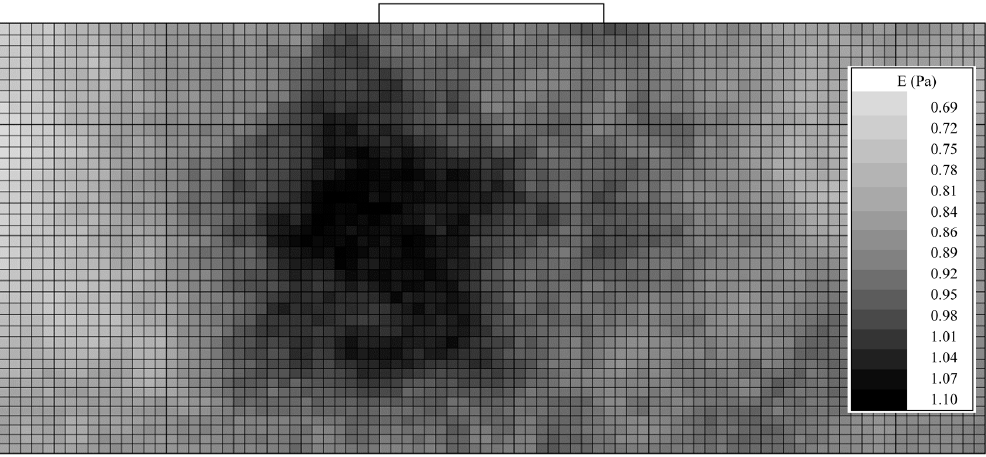
Figure 12. Graphical representation of the random field of E of Example #3 ( B θ = 5; see Table 1).